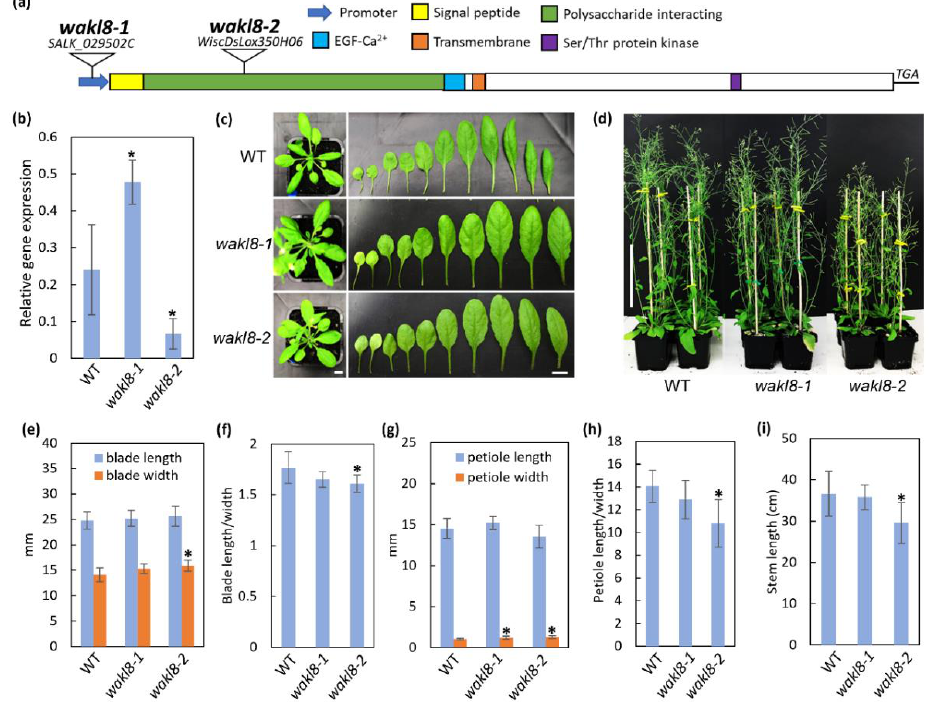
Figure 3. Identification of T-DNA insertions in WAKL8 and analysis of phenotypes of wakl8 mutant plants compared with WT plants. ( a ) Schematic of the WAKL8 coding sequence showing the predicted protein domains and position of the T-DNA inserts for both wakl8-1 and wakl8-2 . The WAKL8 transcript is predicted to encode an N-terminal signal peptide (yellow), followed by a putative extracellular polysaccharide-interacting domain (green), epidermal growth factor-Calcium interacting domain (EGF-Ca 2+ ) (blue), single transmembrane domain (orange), and cytoplasmic Ser/Thr protein kinase domain (purple). The T-DNA in the wakl8-1 mutant is inserted in the promoter region, and for the wakl8-2 mutant, the T-DNA is inserted in the first exon. ( b ) Q-PCR analysis of WAKL8 . Expression levels are relative to ACT2 and show slightly increased WAKL8 transcript levels in wakl8-1 plants and decreased WAKL8 transcript levels in wakl8-2 plants compared with WT plants. Data shown as average ± SD. n ≥ 3 plants. ( c ) Representative image of WT, wakl8-1 , and wakl8-2 mutant